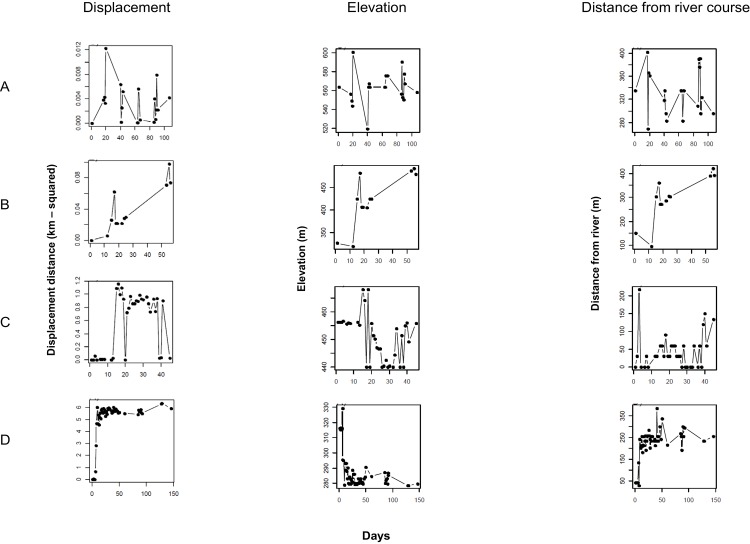
Example of changes in possum movement patterns over time.Data represent changes in the squared displacement over time (left hand column), and changes in elevation and distance from the main river at the Upper Ahaura site (right hand two columns) over time of mean daily locations for: (A) an adult male with a settled home range; (B) an adult female with a shifting home range; (C) a sub-adult male showing exploratory movements, and; (D) a sub-adult male dispersing a long distance. Note the different scales for the y-axes.